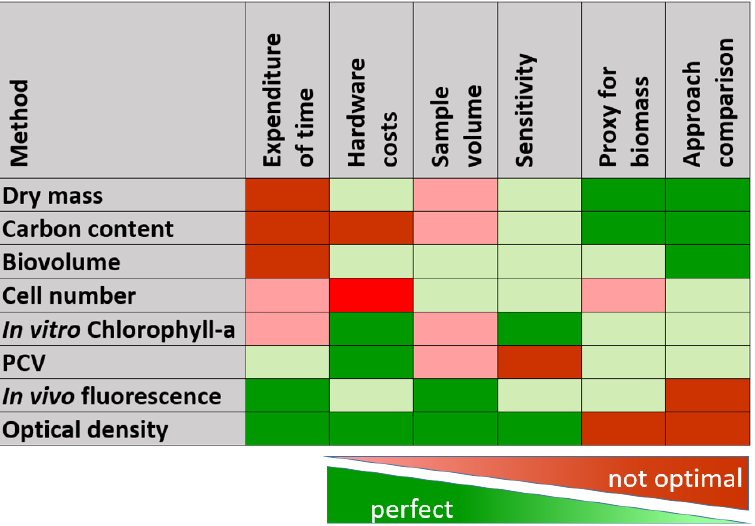
Figure 12. Summary of commonly used methods for estimating microalgal biomass (PCV = packed cell volume, in vitro Chlorophyll-a = spectrophotometric chl-measurement after solvent extraction). Colors represent the suitability for the respective property.